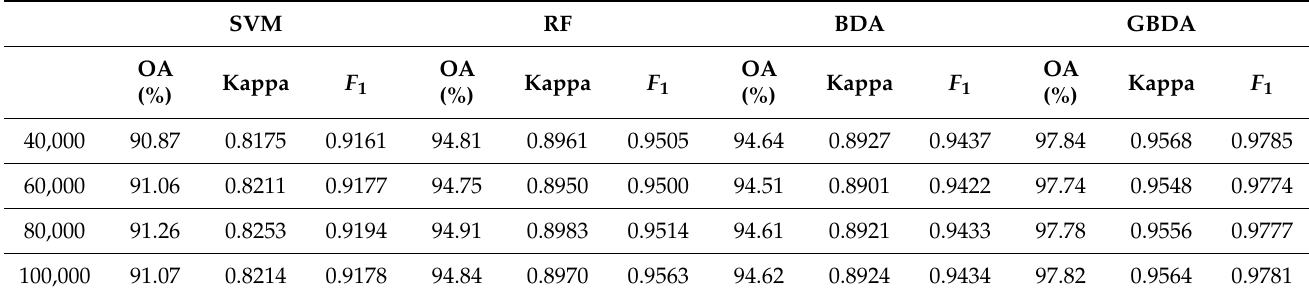
Table 1. Accuracy assessment of impervious surfaces of GF-2 remote sensing